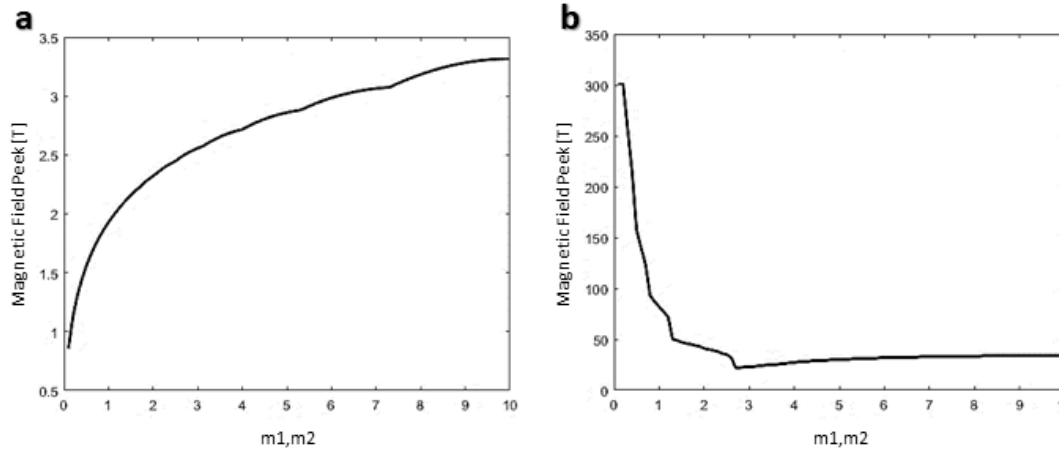
Figure 13. Effect of the controller parameters on the settling time and magnetic field peak. ( a ) Maximum magnetic field peak needed when the 𝑚 parameters change from 0 to 10 ( b ). Settling time corresponds to 𝑚 parameters, showing that, by increasing the 𝑚 , settling time is reduced. Lower settling time means a higher speed of reaching the targets.